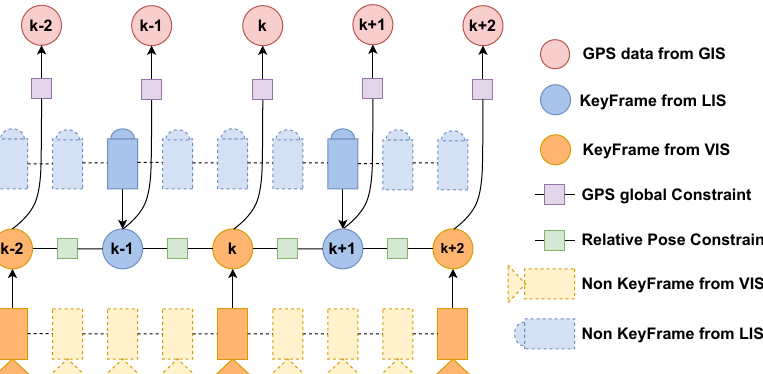
Figure 6. The block diagram of pose graph